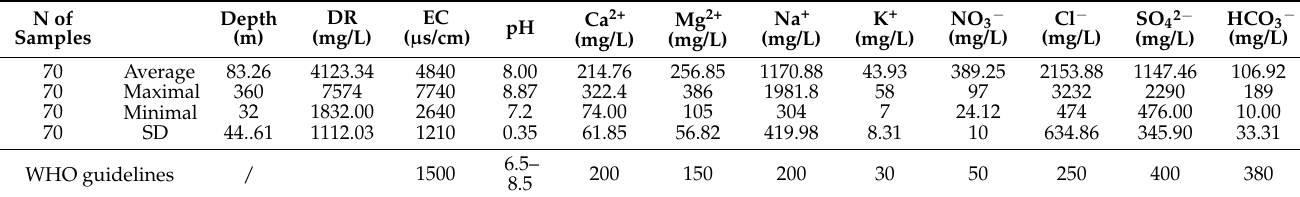
Table 2. Statistical presentation of the groundwater